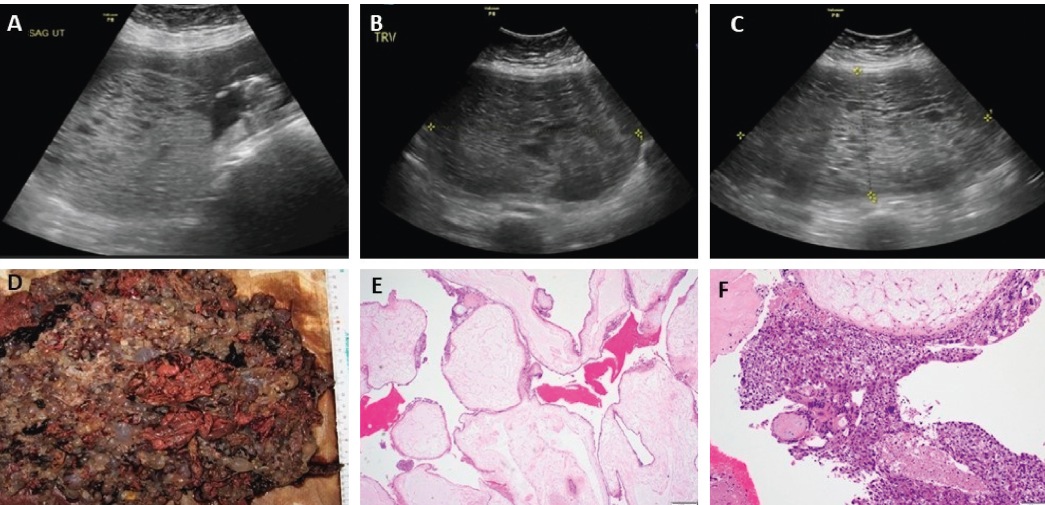
Figure 1: Ultrasound imaging of twin gestation (complete HM and coexisting normal fetus) at 14 weeks (a), 22 weeks (b), and 24 weeks (c). Histologic examination: (d) gross appearance with multiple tan-gray semitransparent vesicles of variable size admixed with solid fragments of tan-brown soft tissue and blood clot with no fetal parts; (e) diffuse villous enlargement with marked hydropic change; absent p57 immunostain (not shown) supporting the diagnosis of complete hydatidiform mole; (f) circumferential trophoblastic proliferation with focal necrosis and cytologic atypia, characteristics of complete